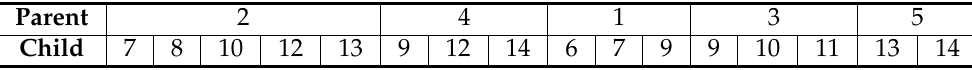
Table 2. Sorting of parent in decreasing order of children at level